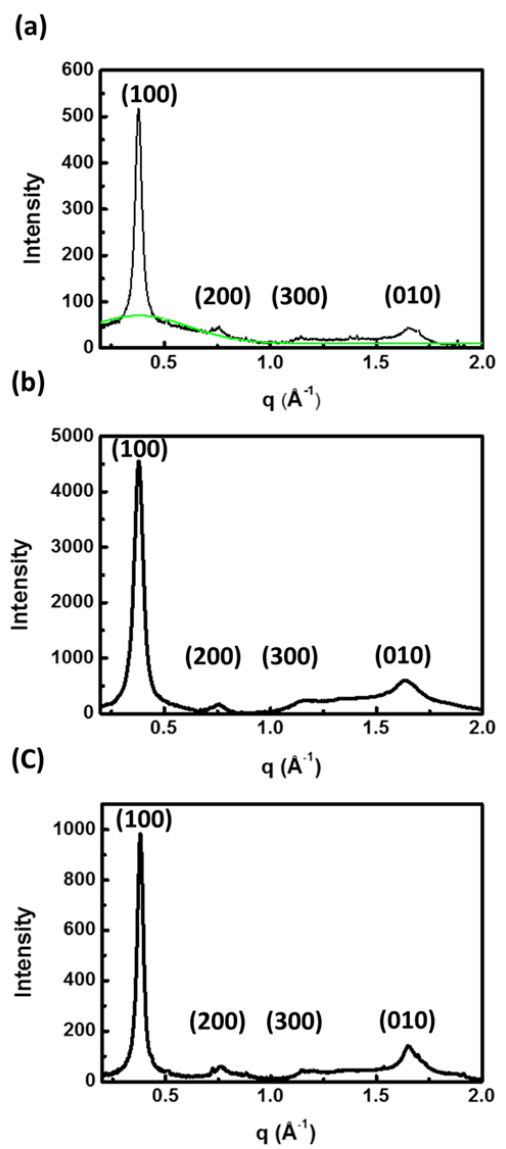
Figure 8. Transmission-mode X-ray diffraction patterns of nanofibers prepared from ( a ) CF, ( b ) CB and ( c ) TCB systems.